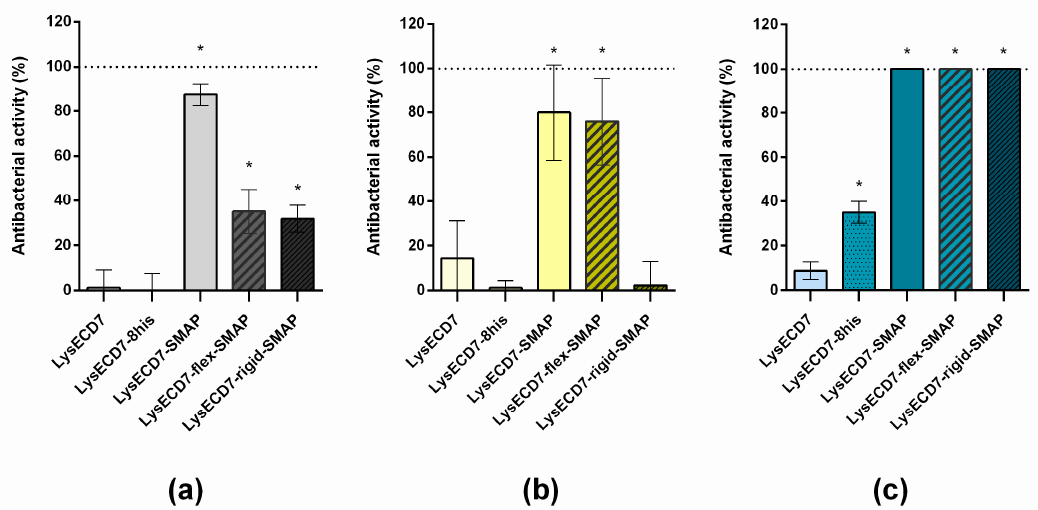
Figure 5. Bactericidal activity of the modified endolysins. ( A ) Activity of the endolysins against A. baumannii Ts 50-16, diluted in a PBS bu ff er solution (protein concentration of 1 µ g / mL); ( B ) activity of endolysins against A. baumannii Ts 50-16, diluted in human serum (protein concentration of 10 µ g / mL); ( C ) activity of lysins against the stationary-phase cells of A. baumannii Ts 50-16, diluted in 20 mM Tris HCl bu ff er pH 7.5 (protein concentration of 10 µ g / mL). Culture dilution was 1 to 3 × 10 5 CFU / mL. For all experiments, the mean values are shown from three independent experiments ± SD. An asterisk (*) indicates a significant e ff ect on bactericidal activity compared to the LysECD7 enzyme ( p < 0.05, one-way ANOVA, Dunnett’s multiple comparisons